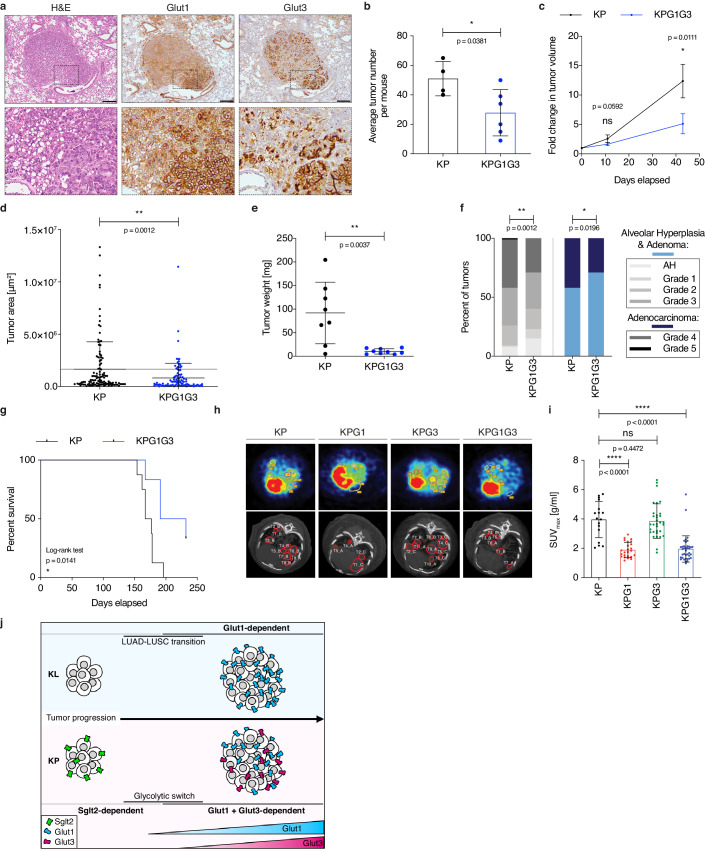
Combined Glut1 and Glut3 deletion impairs lung tumor growth.(a) Representative examples of H&E, Glut1 or Glut3 staining by IHC from serial sections of a KP tumor showing Glut1-3 co-localization. Scale bars: 200 μm. (b) Histogram with mean ± s.d. shows the average number of KP and KPG1G3 tumors per mouse (n = 4 and 6 mice). *: p < 0.05 by Mann-Whitney test. (c) Graph with mean ± s.e.m. shows the fold changes of KP and KPG1G3 tumor volumes (n = 8 and 9 tumors) monitored during 43 days by μCT, starting at 15 weeks and 2 days post-tumor initiation with tumor volumes set to 1. ns: not significant by Mann-Whitney test; *: p < 0.05 by Mann-Whitney test. (d) Dot plot with mean ± s.d. shows tumor areas in KP and KPG1G3 mice (n = 115 and 101 tumors) calculated from lung sections. **: p < 0.01 by Mann-Whitney test. (e) Dot plot with mean ± s.d. shows KP and KPG1G3 tumor weights (n = 8 and 9 tumors, respectively) at sacrifice. **: p < 0.01 by Mann-Whitney test. (f) Percent of KP (n = 150) and KPG1G3 (n = 170) lesions classified by tumor grades, either detailed from alveolar hyperplasia (AH) to grade 5 or discriminated between alveolar hyperplasia and adenomas, and adenocarcinomas. Alveolar hyperplasia and adenomas include the AH and the tumor grades 1, 2, and 3. Adenocarcinomas contain the tumor grades 4 and 5. *: p < 0.05; **: p < 0.01. Fisher test was applied when comparing AH, grade 1, grade 2, grade 3, grade 4, and grade 5. Chi-square for trend was applied when comparing alveolar hyperplasia and adenomas, and adenocarcinomas. (g) Kaplan-Meier survival analysis of KP (n = 8) and KPG1G3 (n = 6) mice. *: p < 0.05 by Log-rank test. (h) Representative (upper panels) positron emission tomography (PET) scan and (lower panels) μCT scan images illustrating the 18F-FDG absorption of KP, KPG1, KPG3 and KPG1G3 tumors. (i) Dot plot with mean ± s.d. displays maximum standardized uptake value (SUV max ) of KP (n = 17), KPG1 (n = 24), KPG3 (n = 32) and KPG1G3 (n = 38) lesions. ns: not significant by Mann-Whitney test; ****: p < 0.0001 by Mann-Whitney test. (j) Model illustrating the dependency on glucose transporters for KP and KL tumor progression.Figure 4—source data 1.Source files for tumor growth, grades and survival of KP and KPG1G3 mice.